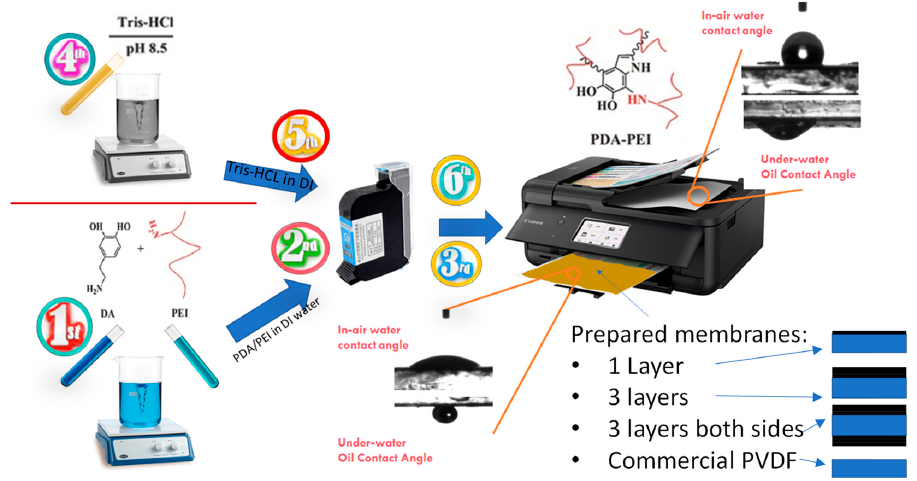
Figure 1. Schematic of the solution preparation and procedure for inkjet printing modification of a commercial hydrophobic membrane. The lower right figures show the schematic representation of the coating configurations of the prepared membranes.